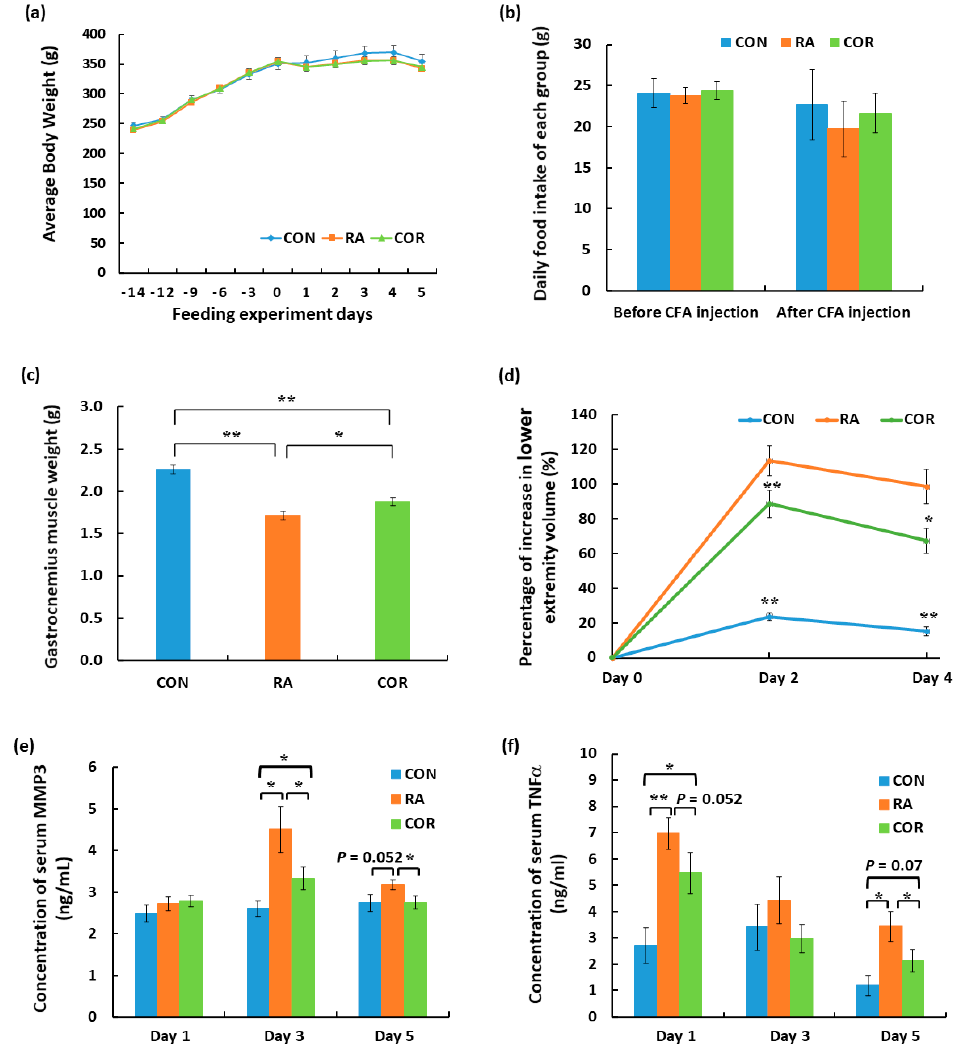
Figure 1. Physiological index and measurement of biomarkers of rheumatoid arthritis (RA) in each group. ( a ) Average body weight, ( b ) daily food intake of each individual in each group, ( c ) gastrocnemius muscle weight, ( d ) percentage of increase in lower extremity volume, and ( e ) MMP3 and ( f ) TNF α serum levels. CON: negative control group; RA: rats with RA induction; COR: rats with RA induction and coriander treatment. Data were expressed as means ± standard errors. ** p < 0.01, * p <